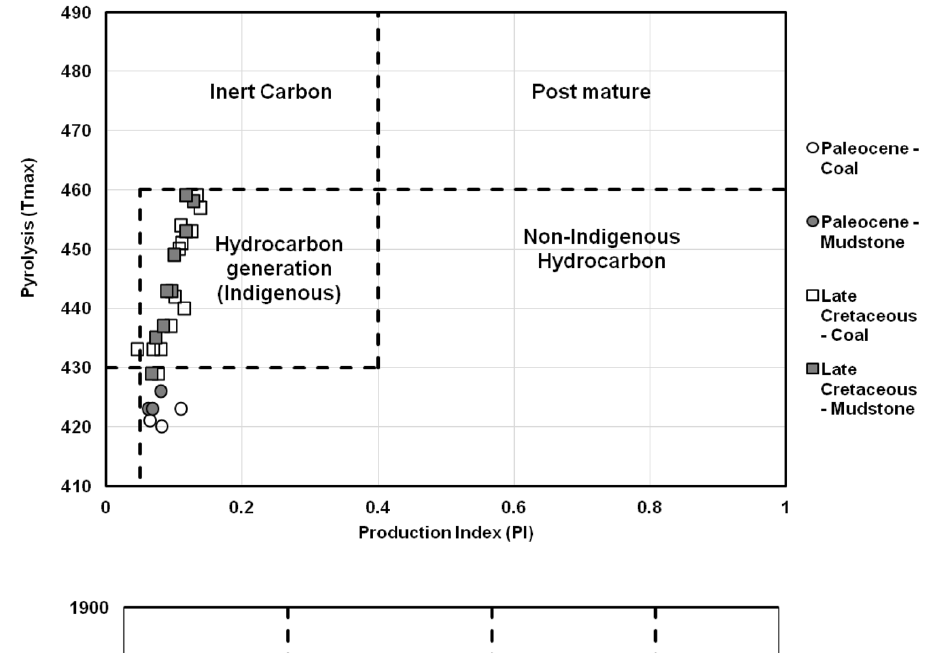
Fig. 10 A cross-plot of maximum pyrolysis temperature ( T max ) versus depth to demon- strate the distribution of the parameter with increasing